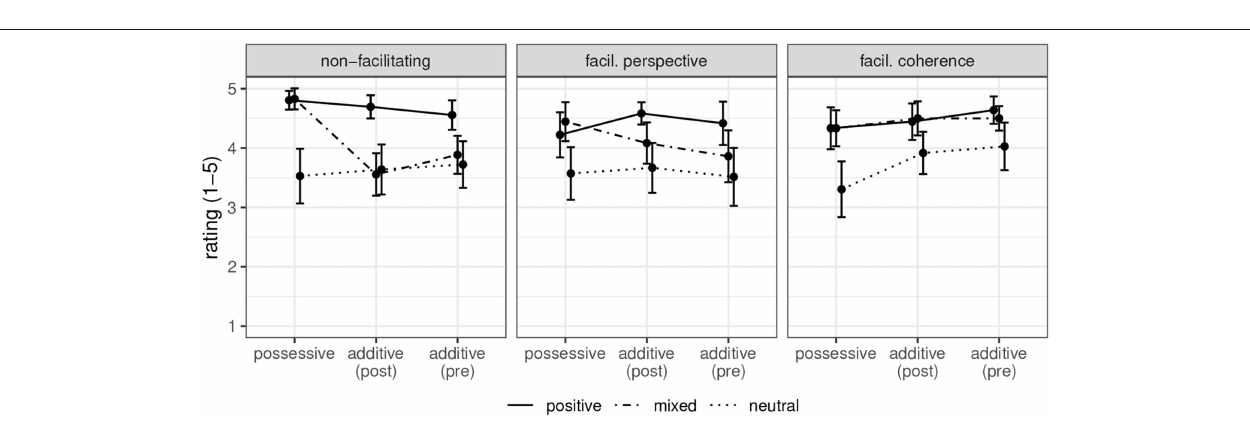
FIGURE 6 | Results of Experiment 2: felicity ratings with 95% confidence intervals (A) and answer proportions (B) .